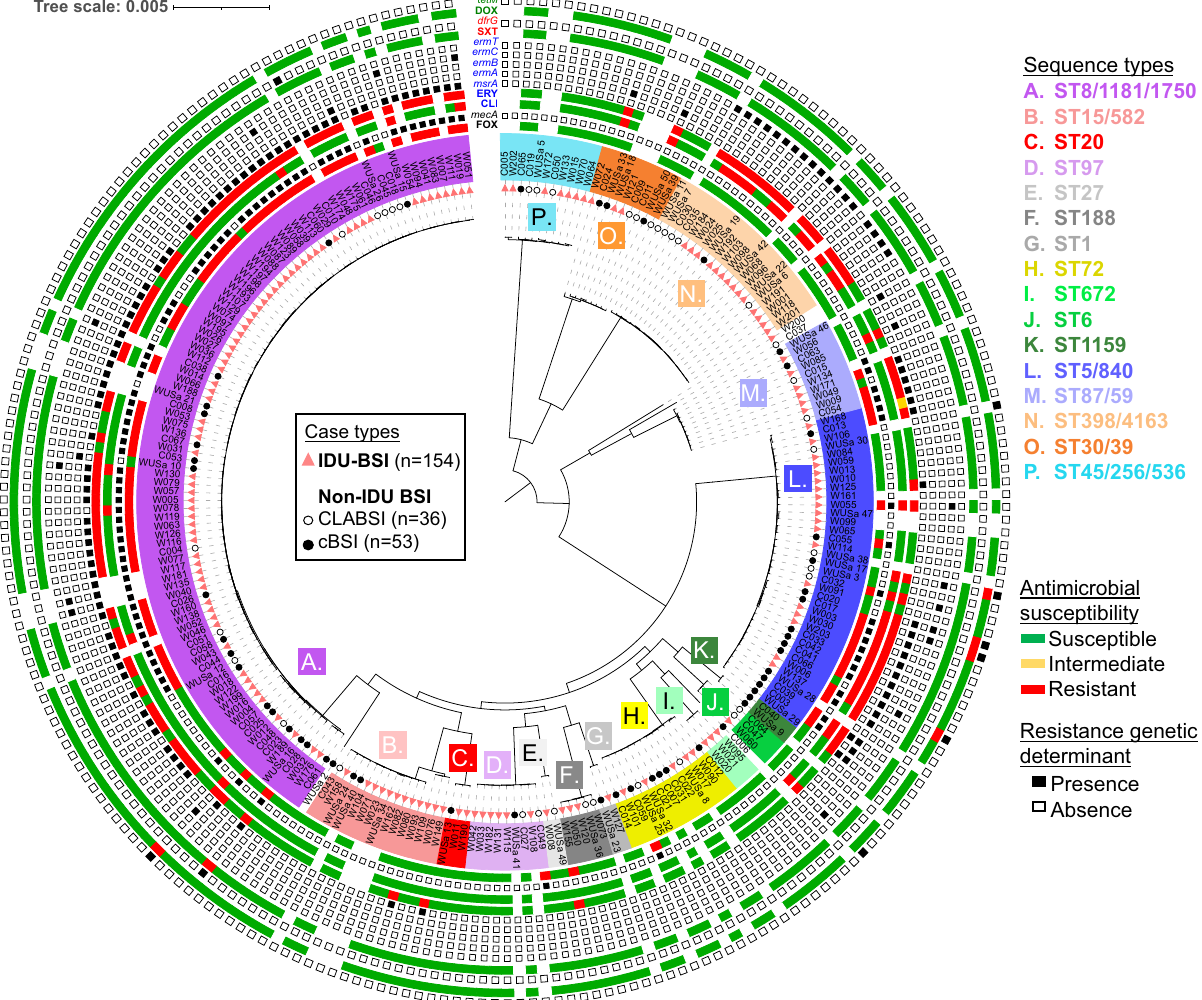
Fig. 3 Phylogeny of BJH S. aureus BSI isolates. Maximum-likelihood phylogenetic tree is based on 86493 core genome SNPs and rooted to midpoint. Black- fi lled circles, un fi lled circles and red triangles on branch tips denote cBSI, CLABSI and IDU-BSI isolates, respectively. Isolate names are highlighted with colors denoting the multilocus sequence type (ST) identity of each isolate. Single and double-locus variant STs that exclusively share a common ancestor, are grouped in 16 ST groups. Outer rings denote an isolate ’ s antibiotic susceptibility according to electronic medical records (multicolored strip) and the presence/absence of attributable genetic determinants according to WGS (adjacent squares). Antibiotic and gene name labels are color coded according to pertinent antibiotic class. FOX, cefoxitin; CLI, clindamycin; ERY, erythromycin; SXT, trimethoprim/sulfamethoxazole; DOX, doxycycline. Figure metadata included in Supplementary Data